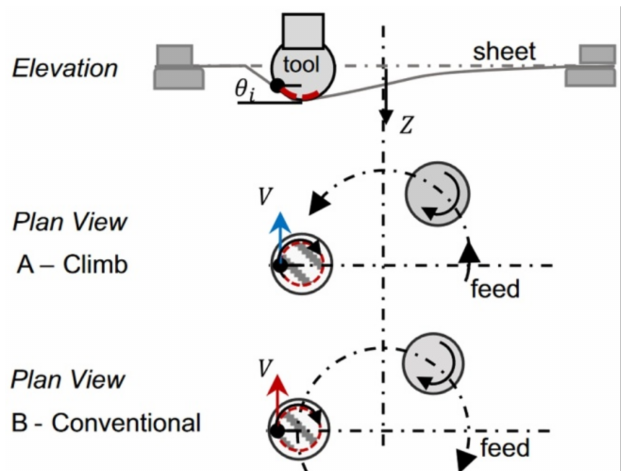
Figure 15. The concept of conventional and climb SPIF (reproduced with permission from